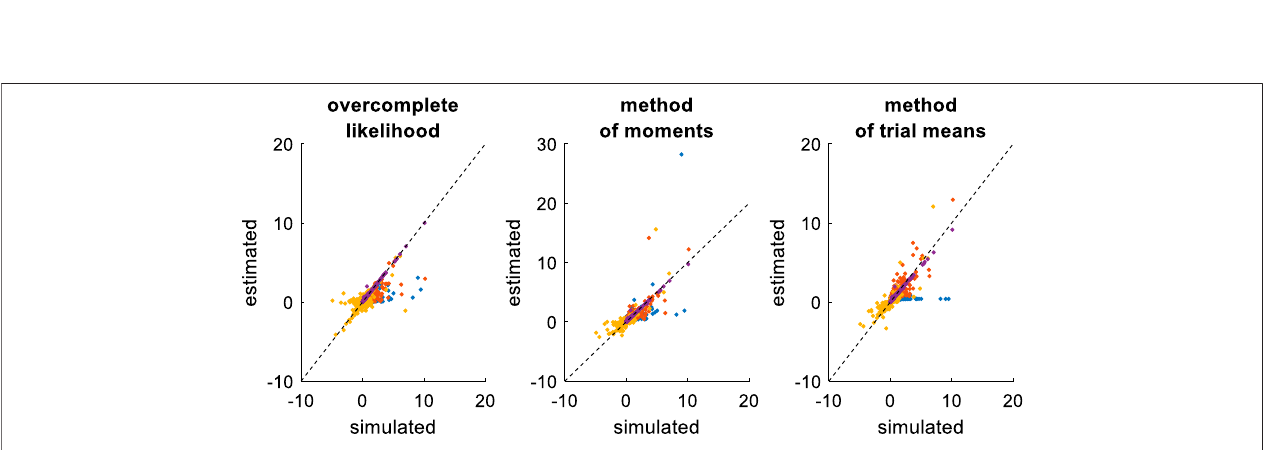
FIGURE 9 | Comparison of simulated and estimated DDM parameters ( fi xed drift rates). Same format as Figure 7 , exceptfor the color code in upper panels (blue: σ , red: b , yellow: x 0 , purple: T ND ).